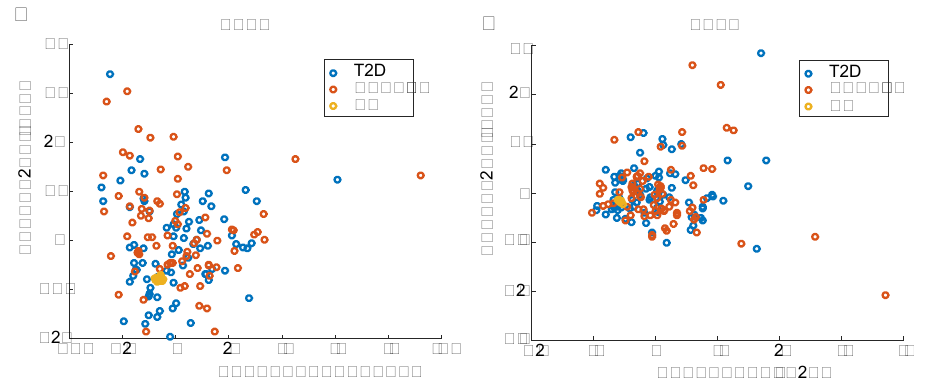
Figure 3. PCA was applied to features after preprocessing of LCMS measurements. The quality control (QC) samples were found to be well clustered near the center of the scores plot in both ( A ) positive and ( B ) negative ionization mode. Control and type 2 diabetes (T2D) samples, however, do not exhibit any meaningful separations. Quality of the dataset is first assessed using principle component analysis (PCA). Visual inspection of the clustering of the QC samples and drift of the run order QCs in the PCA scored plots were performed to assess the data integrity by tight clustering of the QC samples on the PCA score plots 63 . The percentage variance explained by each principle components is shown beside the axis